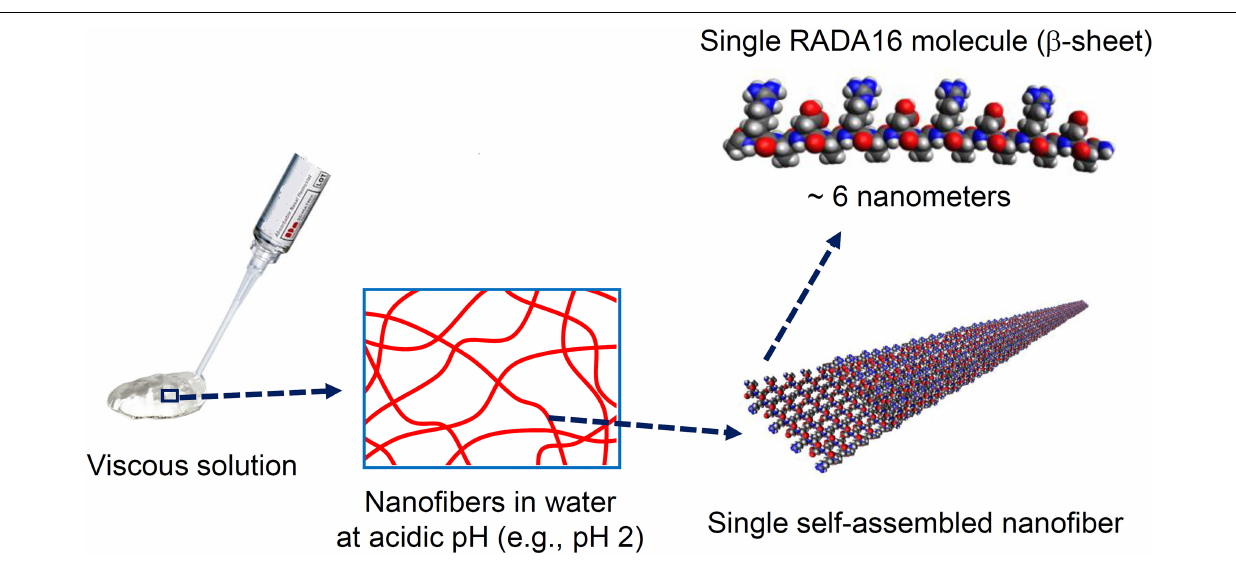
FIGURE 2 | Macro, micro, and nanostructures of RADA16 in an aqueous solution. Spontaneous and reversible self-assembly of RADA16 molecules occurs in acidic solutions to generate nanofibers. RADA16 molecules with β -sheet conformation interact through face-to-face hydrophobic interactions and edge-to-edge hydrogen bonding to form layered and extended nanofibers, ∼ 6 nm in width. These ECM-like nanofibers form a viscous and transparent aqueous solution at a relatively low concentration range (e.g., 0.1 ∼ 2.5%